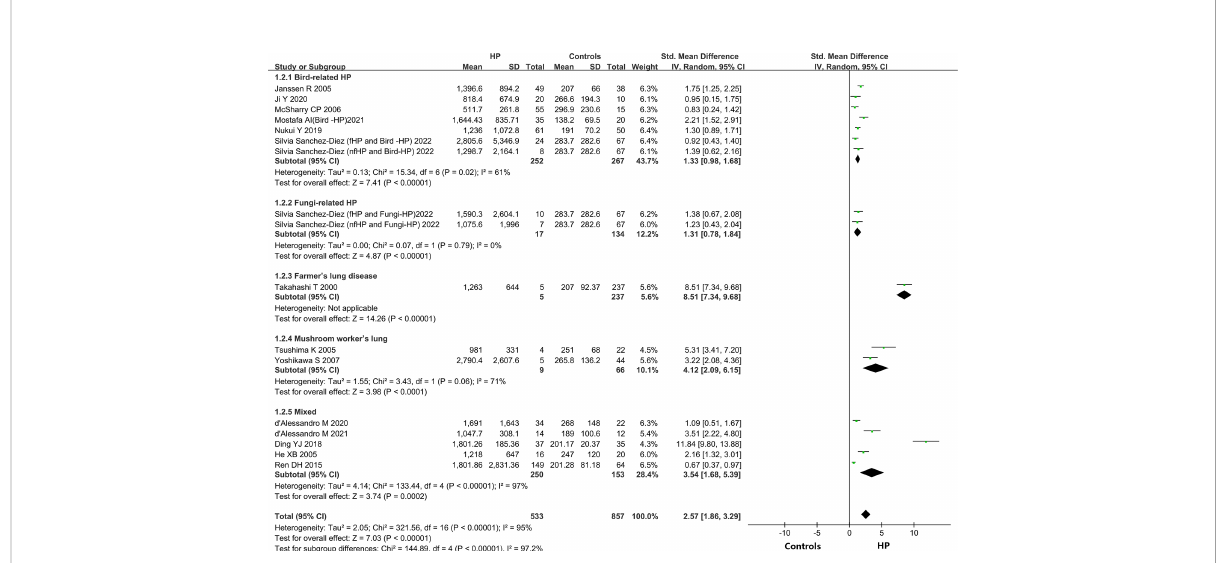
FIGURE 3 Subgroup analysis depended on different allergenic